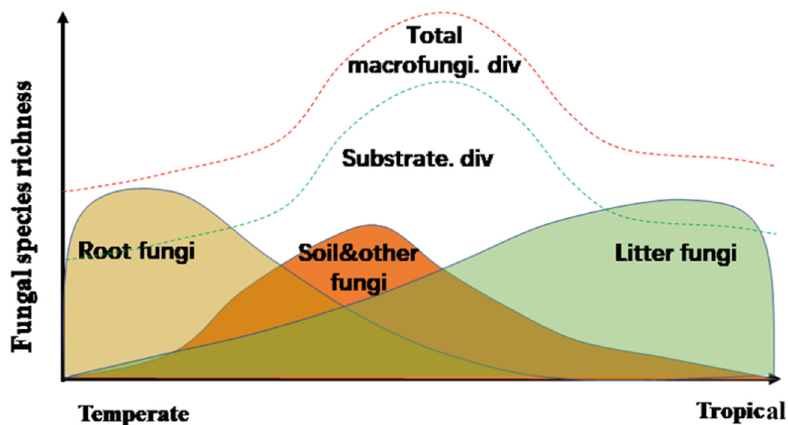
Figure 5. Conceptual diagram of the distribution patterns of substrate-specific fungi in secondary forests across latitudinal gradients. We compared substrate diversity with total fungal taxonomic diversity. The x-axis represents climate zones ranging from the temperate to the tropical zone. The y-axis represents macrofungal species richness. Our survey indicated that macrofungi that colonized the soil, litter, and the root showed geologically-separated distribution patterns. Litter fungi dominated in the tropics, whereas root fungi dominated in temperate zones. Macrofungi living on soil and rare substrates were mainly found in subtropical areas near the tropics, where there was also higher macrofungal taxonomic diversity (total macrofungi. div) and substrate utilization diversity (substrate. div).